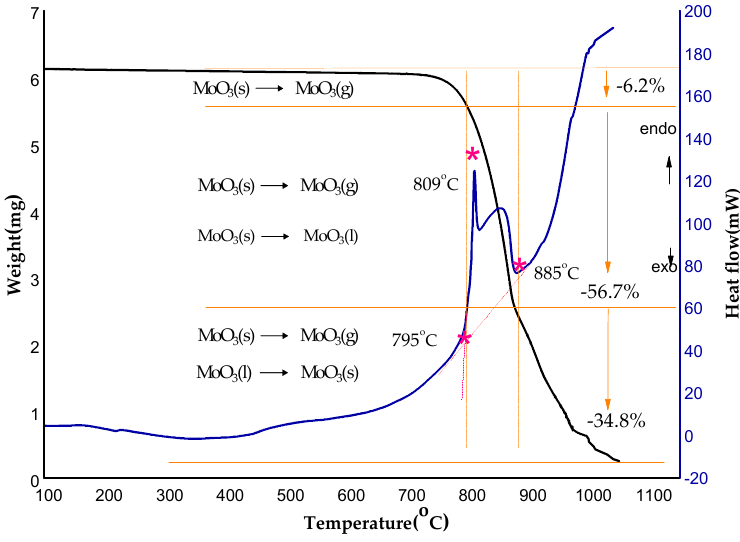
Figure 6. Thermal stability of the recycled Mo-based products.